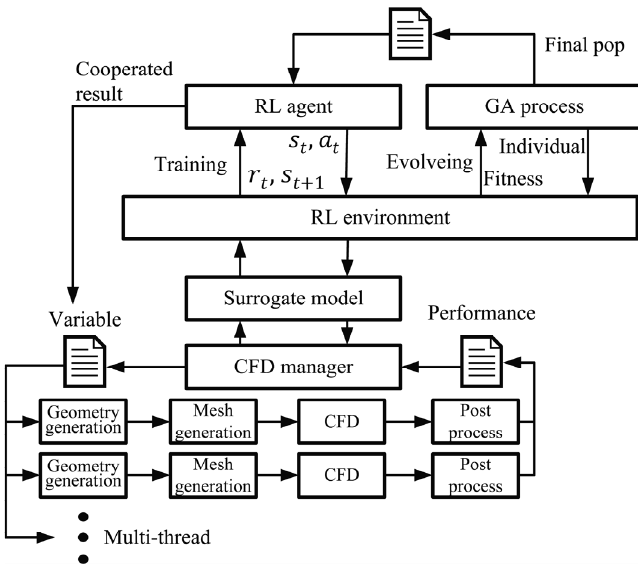
Figure 1. Overall structure of the artificial intelligence design framework, with a hierarchical structure. The CFD manager calculates the operating characteristics of rotors in multiple threads, extracts the performance, and manages the data.